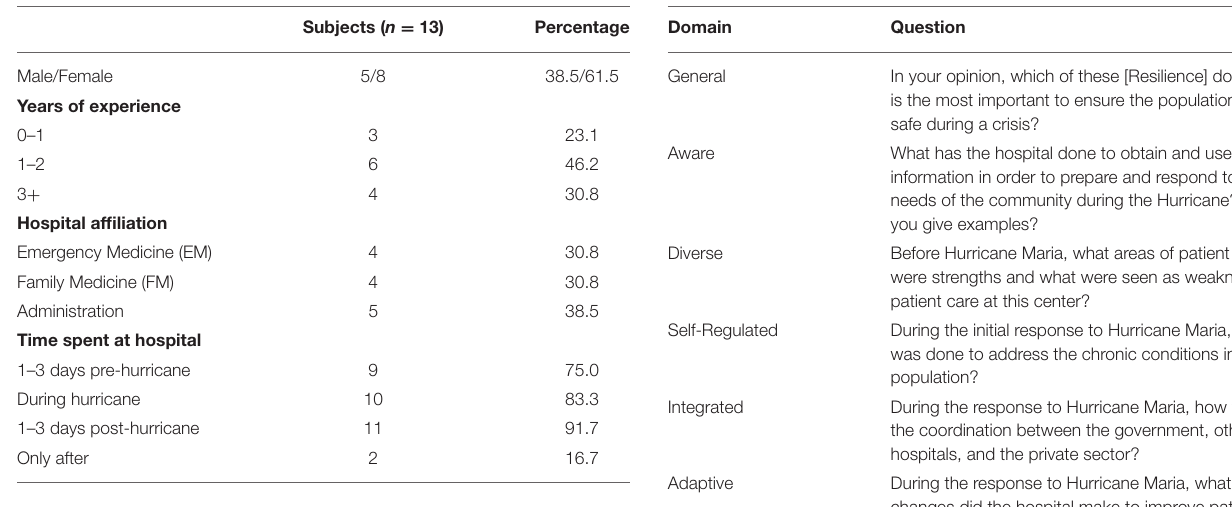
TABLE 1 | Demographics of Respondents. TABLE 2 | Sample Interview Questions by